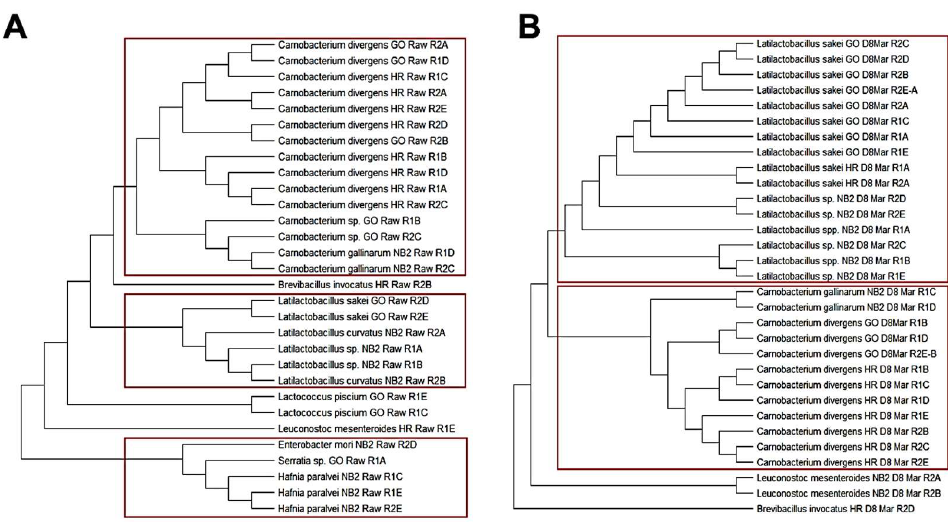
Figure 4. Dendrograms of all isolates obtained and identified from the ( A ) raw beef and ( B ) mari- naded, day 8 dried beef from all three tested beef processors: Greater Omaha (GO), Nebraska Beef (NB2), and High River—JBS (HR). The phylogenic trees were constructed using the Maximum Like- lihood method with pairwise distances estimated using the Maximum Composite Likelihood ap- proach. Evolutionary analyses were conducted in MEGA X software. The red square highlight clades of importance related to the identified isolates and their processor of origin.